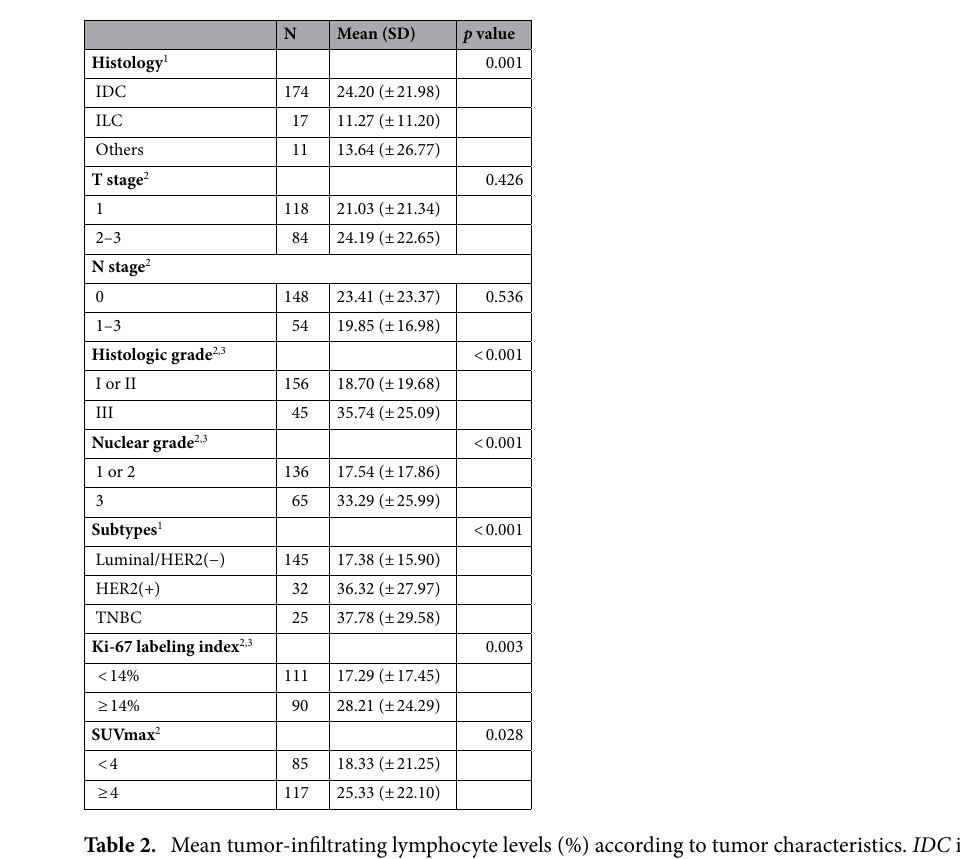
Table 2. Mean tumor-infiltrating lymphocyte levels (%) according to tumor characteristics. IDC invasive ductal carcinoma, ILC invasive lobular carcinoma, HER2 human epidermal growth factor receptor-2, TNBC triple-negative breast cancer, SUV standard uptake value, SD standard deviation. 1 Kruskal–Wallis test. 2 Mann– Whitney U test. 3 Missing